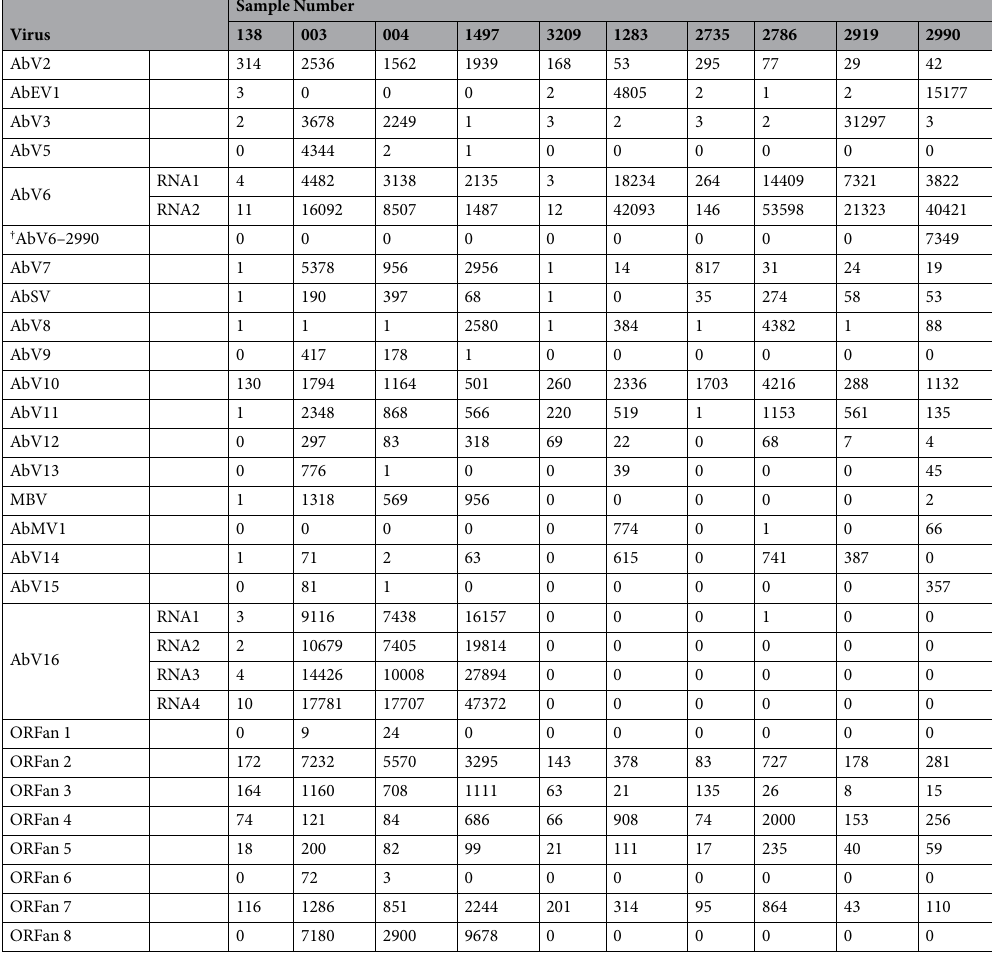
Table 2. Abundance (depth of sequencing coverage) of viral RNAs and ORFans for each sample, determined as number of fragments per kb of transcript per million mapped reads. † AbV6–2990 is a strain of AbV6 RNA1 found in sample 2990.